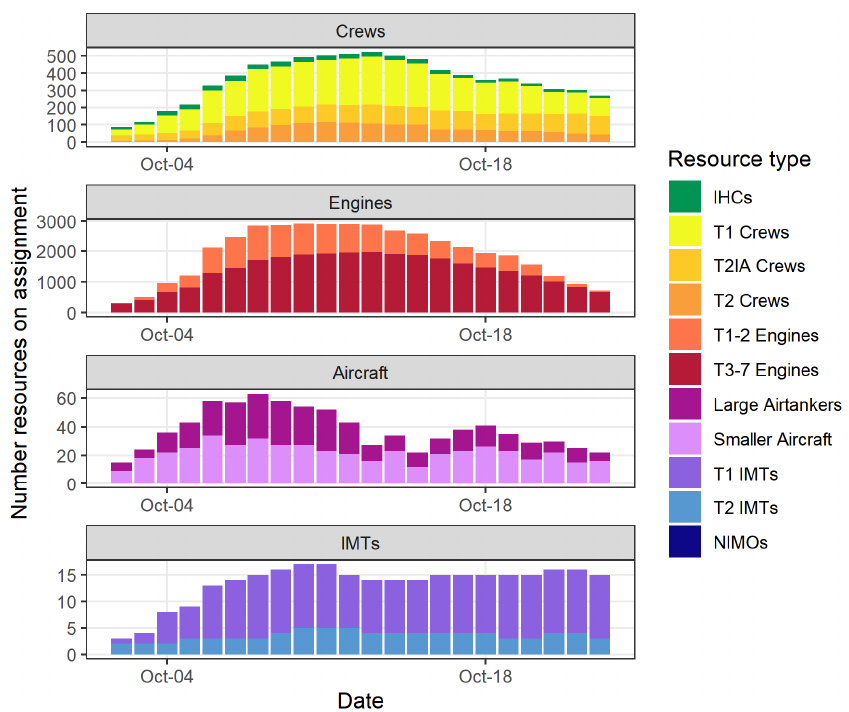
Figure 9. Simultaneous use scenario results. Lining up demand from the three peaks that occurred in 2016, 2017, and 2018 gave us an estimate of what resource demand could look like if the Southern California, Northern California, and Southern geographic areas all saw substantial demand simultaneously.